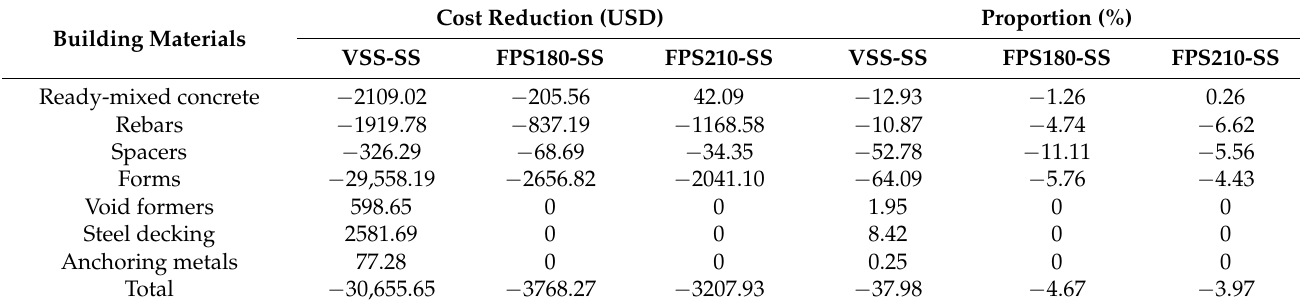
Table 7. Cost reduction from the different structural